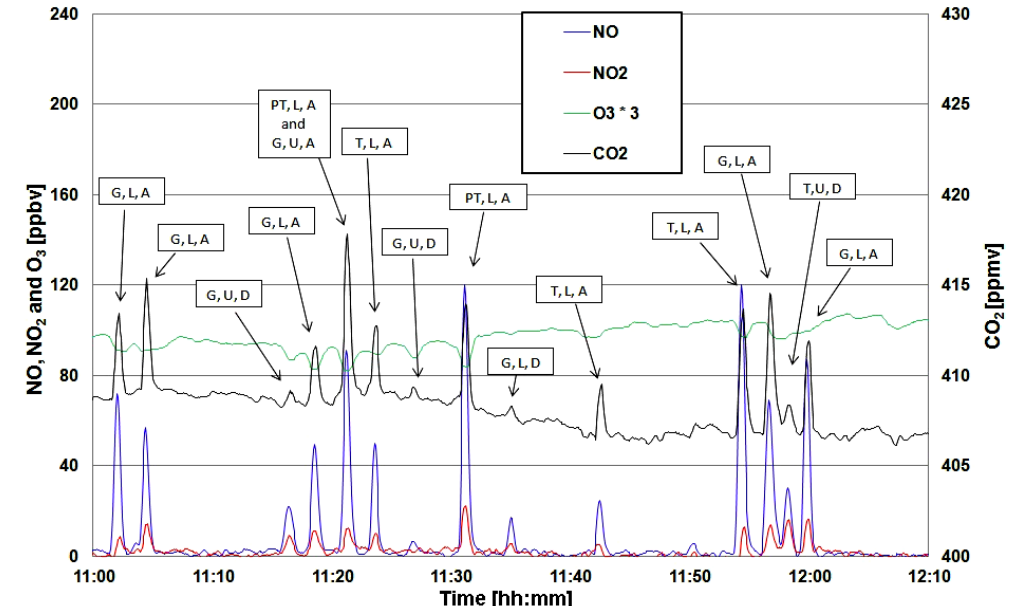
Figure 2. Temporal variation of the NO, NO 2 , O 3 and CO 2 concentration at the measurement site on 20 February 2013 from 11:30 to 14:00LT from different ship types (G = goods ship, T = petroleum tanker, PT = push–tow) and at different operation parameters (L = loaded, U = unloaded, A = upstream and D = downstream).